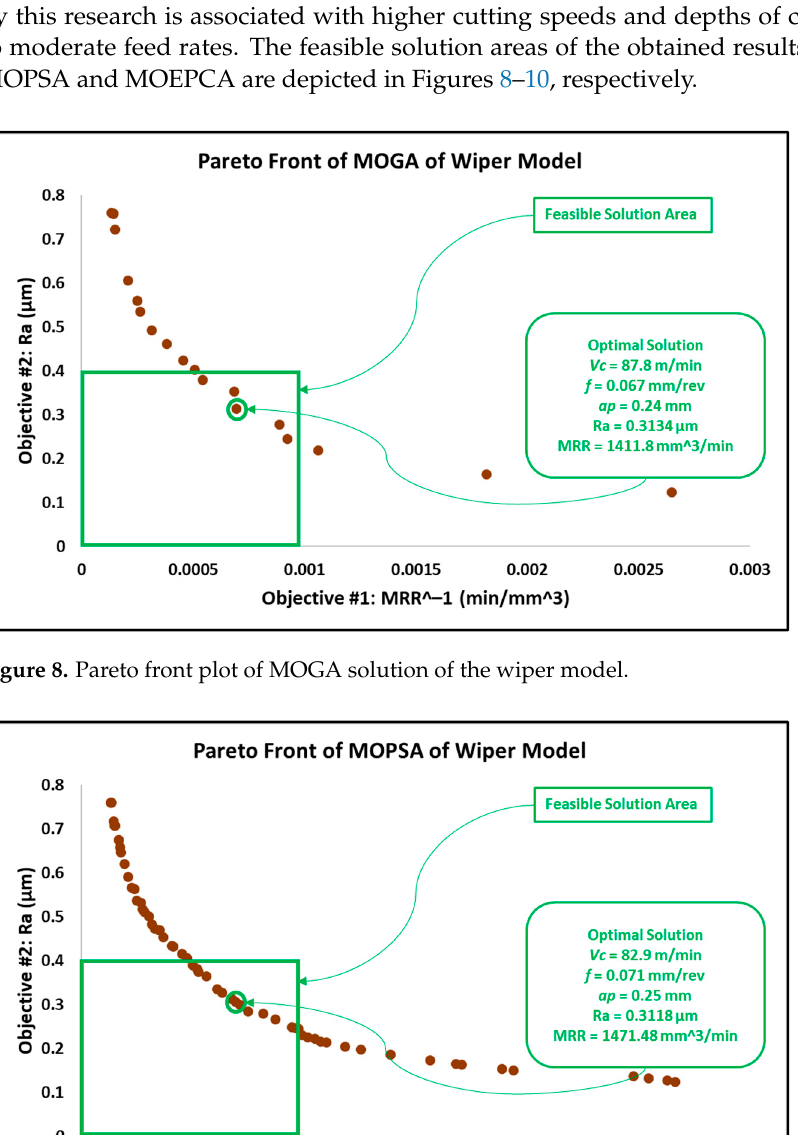
Figure 10. Pareto front plot of MOEPCA solution of the wiper model. The optimal solution of all used techniques is recorded in Table 6. The optimal results of MOGA and MOPSA are significantly close, while MOEPCA shows the best optimal results for the MRR but with a slightly higher surface roughness, which is undesirable. However, the obtained results, compared to [31], show moderate levels of cutting speed, low feed rates and higher depths of cut based on the selected parameter levels. Table 6. The optimal solution results for the wiper model. Parameters